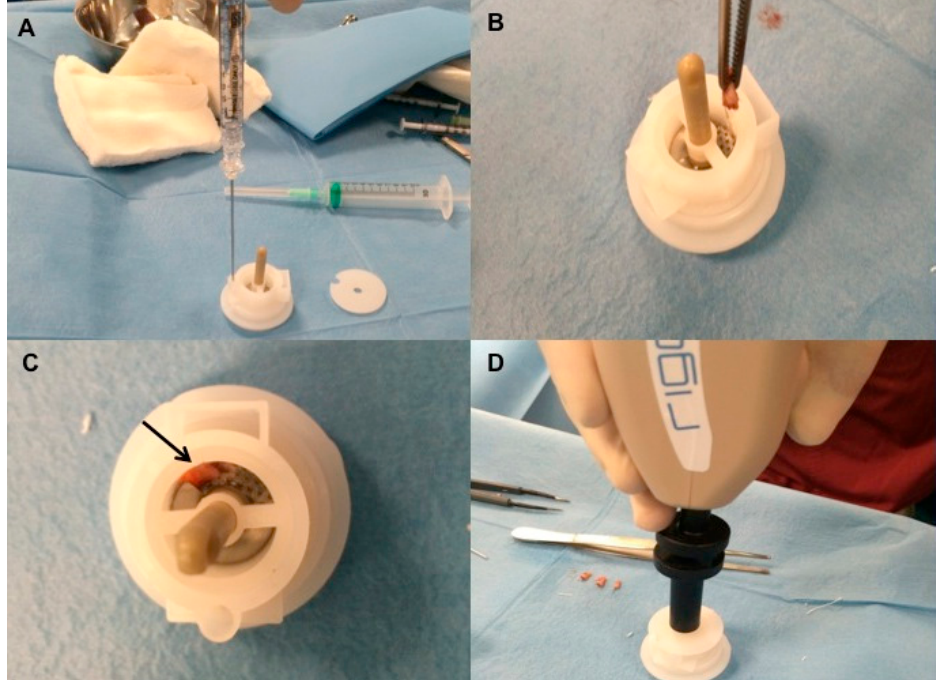
Figure 3. Rigenera procedure phase 2 (positioning of scalp tissue in Rigeneracons and fragmentation by centrifugation). ( A ) The addition of 1.2 mL of physiologic solution into Rigeneracons kit; ( B ) the strips collected into Rigeneracons; ( C ) Deatil of Rigeneracons containing one strip indicated by arrow; ( D ) centrifugation at 80 rpm with Rigenera Securdrill device for 60 s.